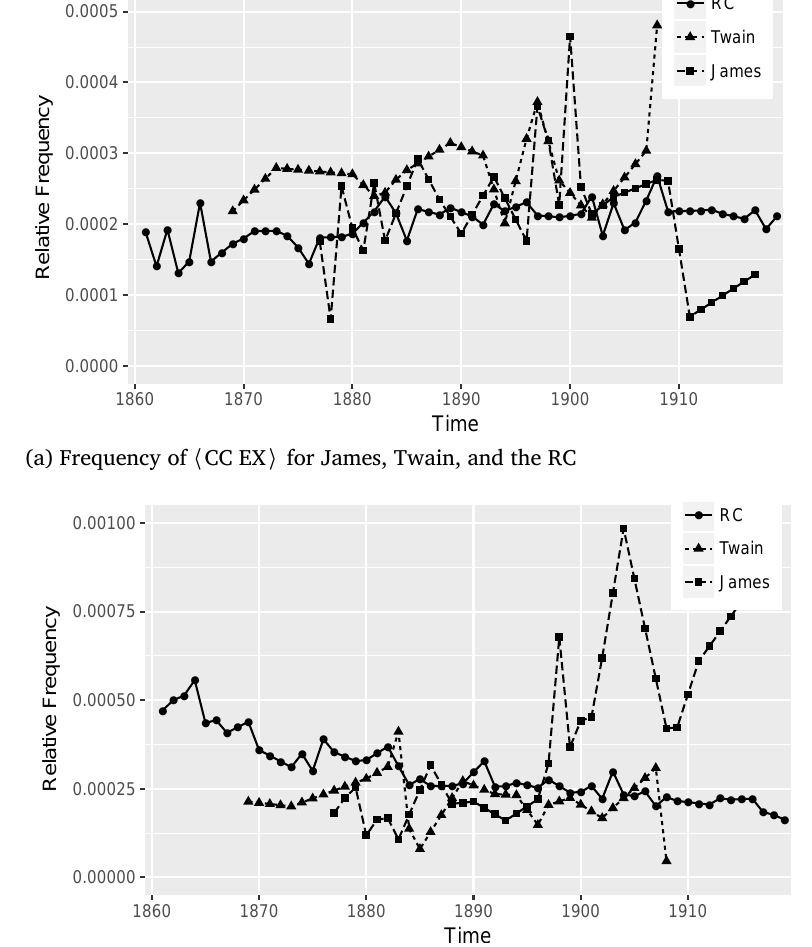
Figure 11: Prominent features